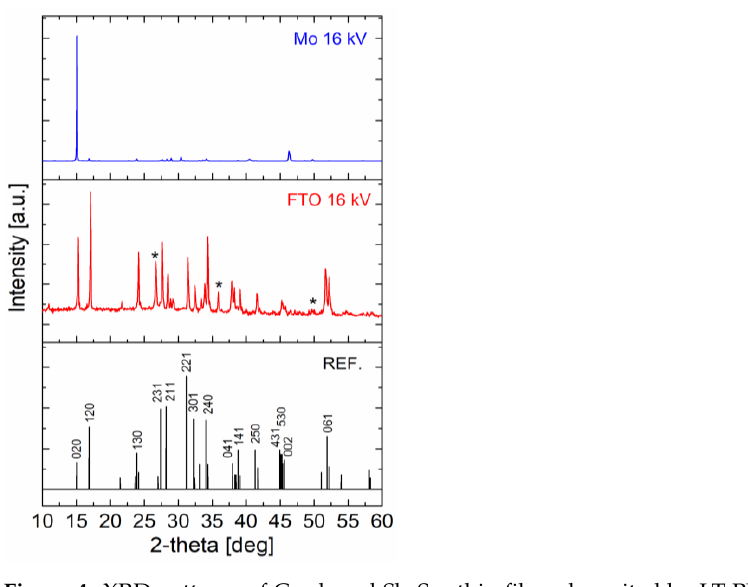
Figure 4. XRD patterns of Cu-doped Sb 2 Se 3 thin films deposited by LT-PED at 16 kV on Mo and FTO substrates; indexed reference (JCPDS 15-0681) for undoped Sb 2 Se 3 is reported at the bottom; * indicates the FTO substrate.